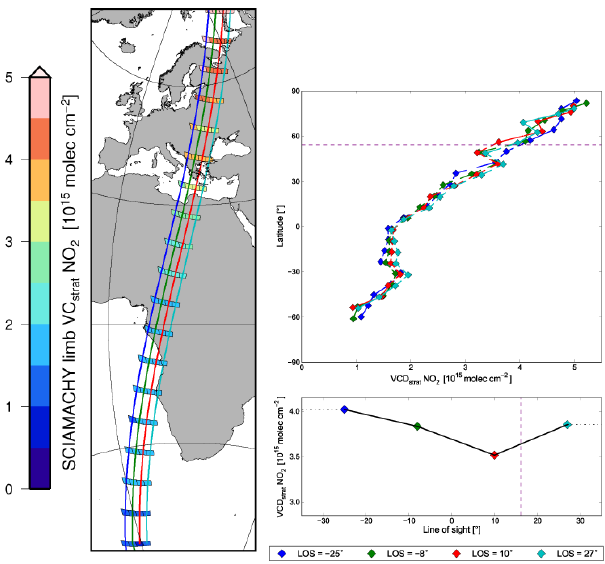
Fig. 2. Interpolation of stratospheric NO 2 columns from SCIAMACHY limb measurements to the location of the same or- bit’s nadir measurements. As an example, we calculate VCD strat for the nadir measurement located at 54.25 ◦ N / 32.25 ◦ E from SCIA- MACHY orbit no. 32984 (21 June 2008). In a first step, each limb state is treated independently. For each state, VCD strat is considered to be a function of latitude only (left). To calculate a VCD strat value for one single nadir measurement, at first, one VCD strat per state is calculated by linear interpolation in latitude (top right). Finally, the VCD strat value corresponding to the nadir measurement of in- terest is calculated by linear interpolation in the line-of-sight angle (bottom